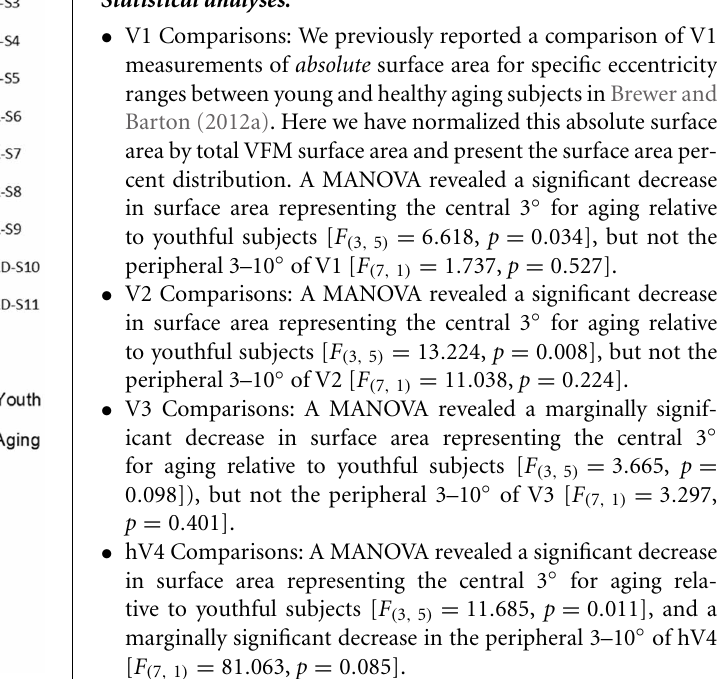
FIGURE 3 | Total surface area measurements for visual field maps. (A) Total surface area for each map for individual young (blue), healthy aging (red), and mild Alzheimer’s disease (green) subjects. (B) Total surface area for each map averaged from ∼ 0.5 to 10 ◦ across youthful subjects (blue bars) and normal aging subjects (red bars). Error bars indicate s.e.m. “ ∗ ” marks statistically significant differences ( p < 0 . 05) between youthful and healthy aging subjects in